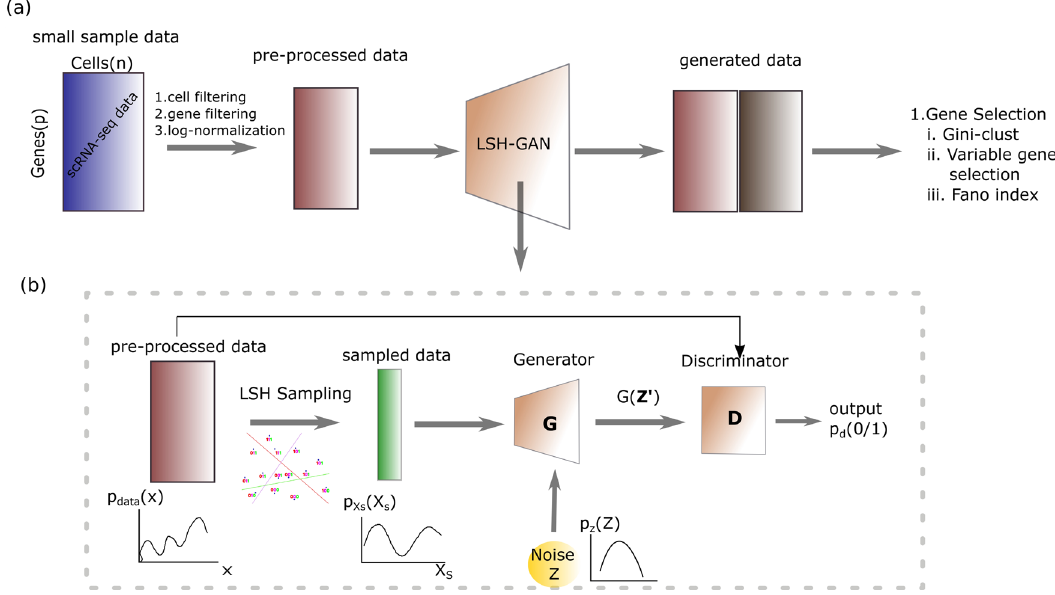
Fig. 1 Work fl ow of LSH-GAN. a Geneselectiontask inHDSSscRNA-seqdata usinggeneratedsampleswith LSH-GANmodel. b